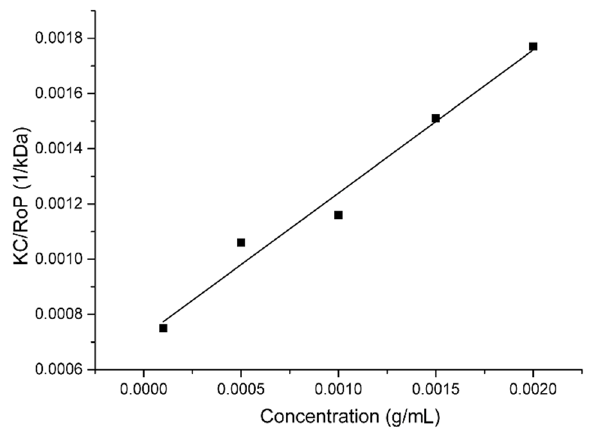
Figure 1. Debye plot of 1 + 2 mixture after CuAAC polymerization (0.01–2 mg/mL).